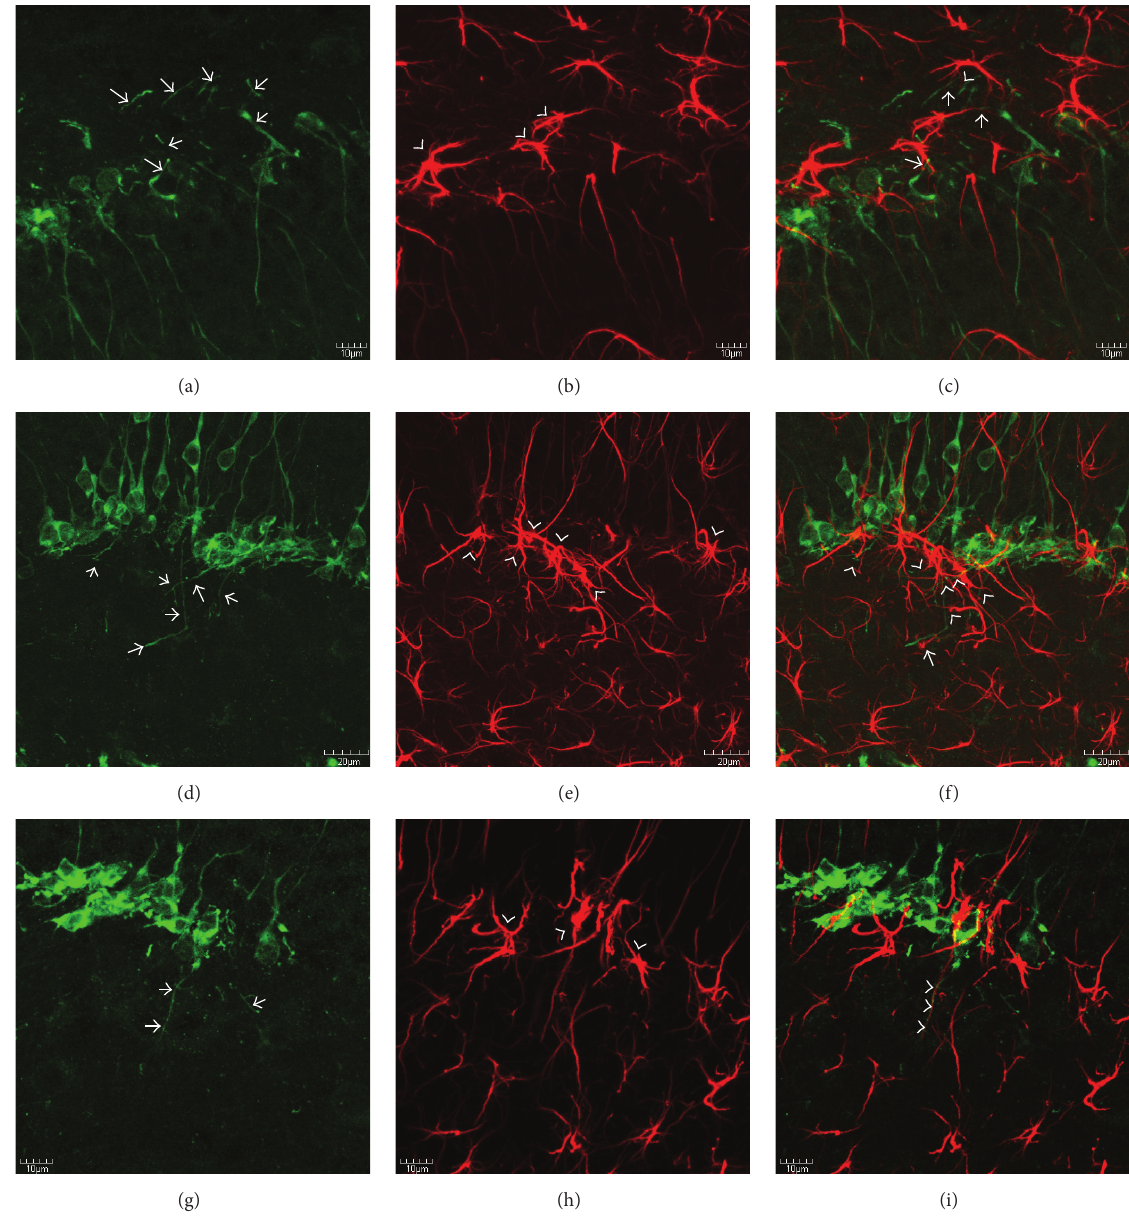
Figure 4: DCX-labeled basal dendrites grow along an ectopic glial scaffold. Confocal micrographs depicting DCX+ (a, d, g), GFAP+ (b, e, h), and merged, double-labeling for DCX (green) and GFAP (red) at 30 days after FPI. Note that (a)–(c) are taken from the infrapyramidal blade, whereas (d)–(i) are taken from the suprapyramidal blade. As can be seen in (a), (d), (g), DCX+ basal dendrites (arrows) are prominent features after FPI, and many of these basal dendrites extend deep into the hilus. Also note, in (b), (e), and (h), the hypertrophied appearance of GFAP+ cells at the base of the granule cell layer (arrowheads). Also note that the predominant orientation of the astrocytes from FPI mice at the border of the granule cell layer is oriented either parallel with the granule cell layer or toward the hilus. Such an orientation is consistent with an ectopic glial scaffold. The lack of radial glial processes extending through the granule cell layer is also notable in (b) and (h). In the merged images (c, f, i) the close relationship between the DCX+ basal dendrites and the GFAP+ processes can be appreciated (arrows). In (i), the apposition of the basal dendrite with the GFAP+ is so close that the two processes almost appear as if they are intertwined (arrowheads). Future studies using electron microscopy will determine if these cells/processes are aberrantly targeted for synaptogenesis in the hilus. Scale bars in (a)–(c) & (g)–(i) = 10 𝜇 m and in (d)–(f) = 20 𝜇 m. In (f) and (i), the appositions of the basal dendrites to the GFAP+ processes are so close that the two almost appear as if they are